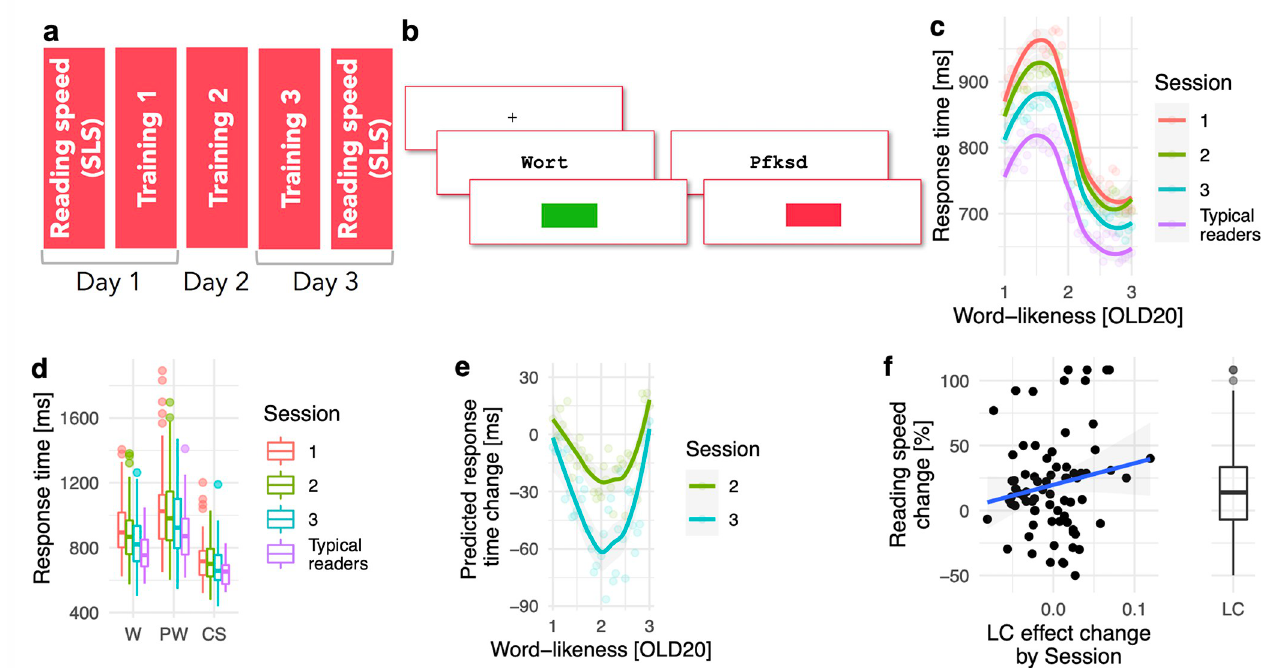
Fig 6. Training-based Evaluation. Behavioral training of lexical categorization: Paradigm and results. (a) Temporal structure of the training study, including the three training sessions on three separate days, as well as pre- and post-training assessments of reading speed (based on the Salzburger Lese Screening/SLS; see Methods). (b) Lexical decision paradigm performed by the participants during the three training sessions, including feedback screens. (c, d) Lexical decision response times in relation to (c) word-likeness (OLD20; i.e., high OLD20 represents low word-likeness; see Fig 1) and (d) separated for stimulus categories (W: Words; PW: Pseudowords; CS: Consonant strings) from 76 non-native learners of German across three sessions. For comparison, data for a group of 48 native German speakers (i.e., typical readers) who completed the lexical decision task with the same stimuli are presented. (e) Predicted response time reduction with session, i.e., from session 1 to 2 (green) and from session 1 to 3 (blue), extracted from fitted linear mixed models using the remef function to remove all but the variance which reflects the session by entropy interaction (for details see the Methods section). (f) Change of reading speed (pre-post; see Methods ) correlated with the individual training effect (quantified as the estimate for the LCM by session interaction from a linear mixed model with random slopes). The boxplot (right panel) shows the overall increase in reading speed on the pre-post test. For all boxplots, the horizontal lines represent the median, the boxes represent +/- 1 standard deviation, and the whiskers represent +/- 2 standard